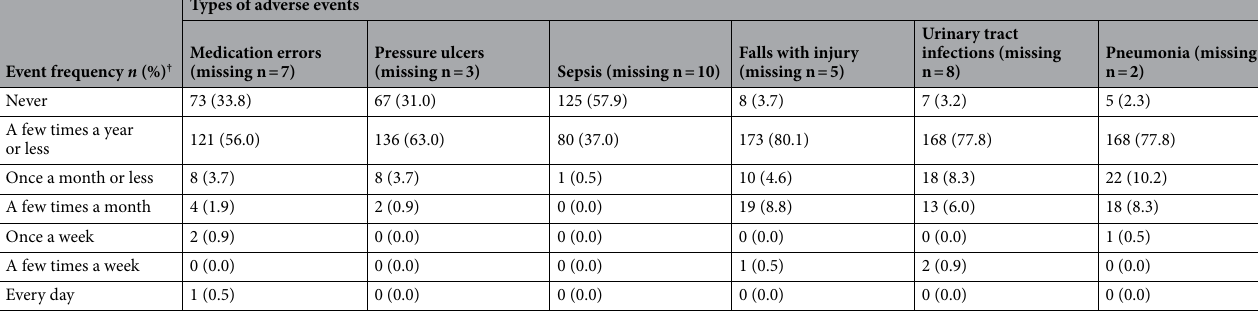
Table 2. Frequencies of adverse events self-reported by RNs in nursing homes (N = 216). † Numbers may not sum up to total sample due to missing data. Percentages also may not sum up to 100% due to missing data. RNs Registered nurses.